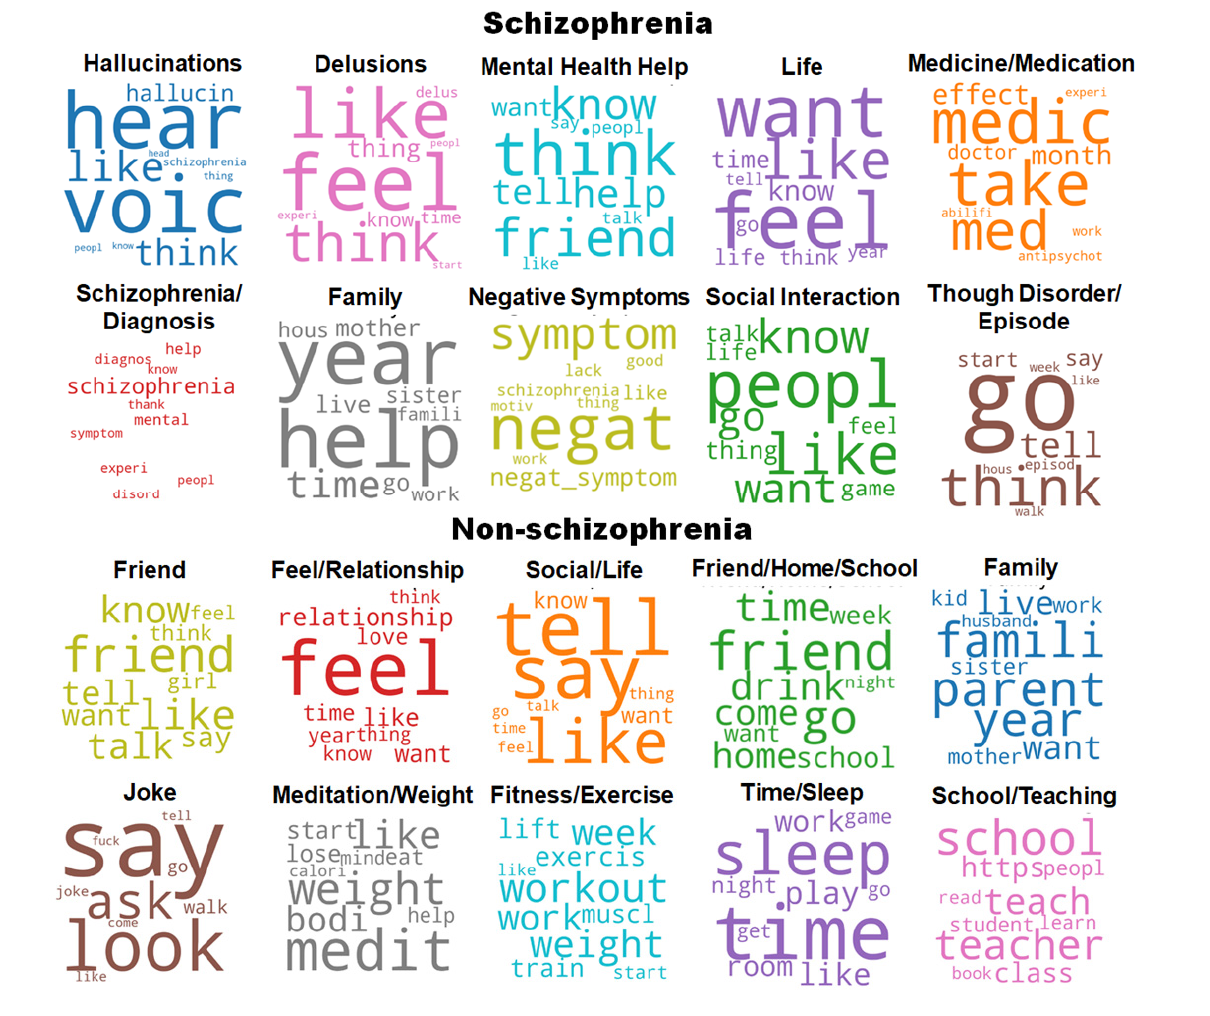
Figure 3. Comparison of the topic distributions between the schizophrenia and the non-schizophre- nia (control) groups within topics identified from the schizophrenia posts. Bars and error bars cor- respond, respectively, to averages and standard deviations across the topic distribution values. All pairwise comparisons show significant differences in topic distributions between the two groups. Schizophrenia has statistically higher topic distributions in “hallucinations”, “delusions”, “negative symptoms”, and “medicine and medication” (all p < 0.001) and lower values in topics of “life” and “family” (all p < 0.001), compared to the control group.